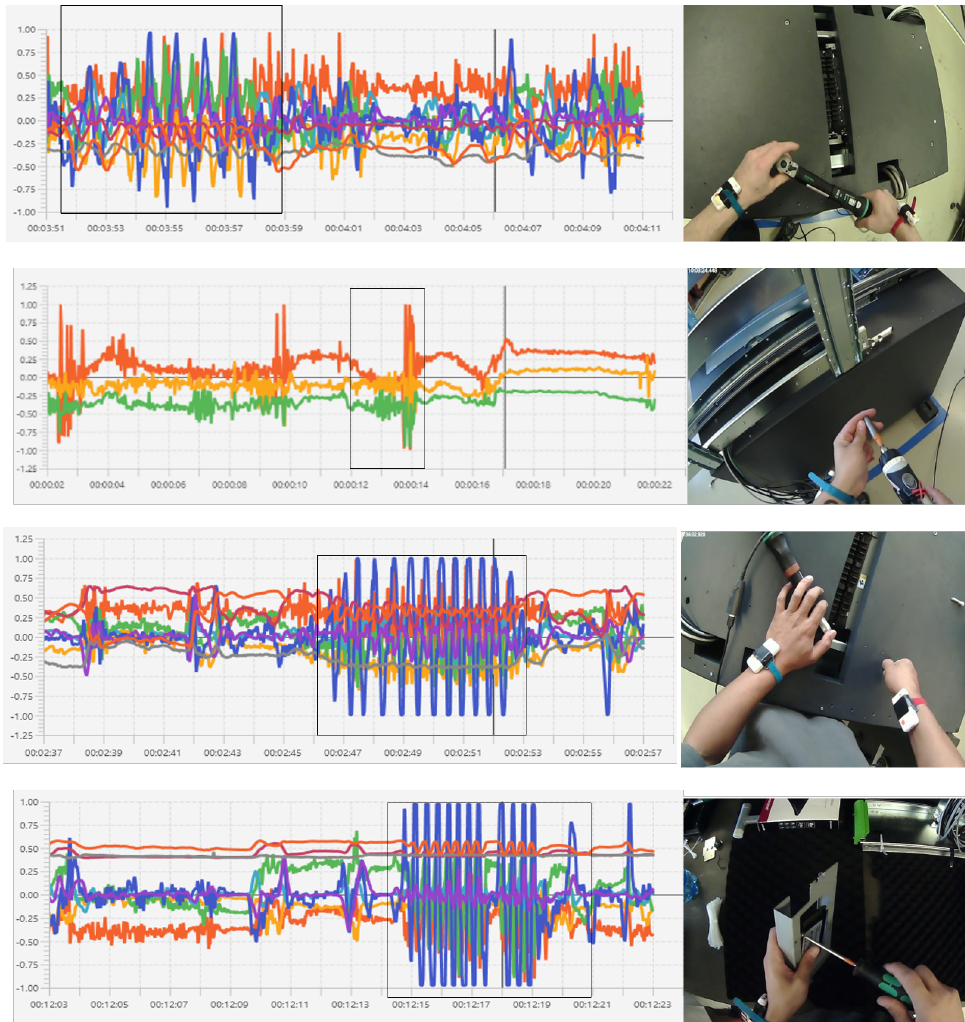
Figure 8. The figure presents exemplary patterns describing micro-activities of macro-worksteps that have occurred during the assembly of a product. The figures on the right are reproduced with permission from [78], IEEE Transactions on Instrumentation and measurement, 2010. From top to down: wrenching, electrical screwing, hand screwing, manual